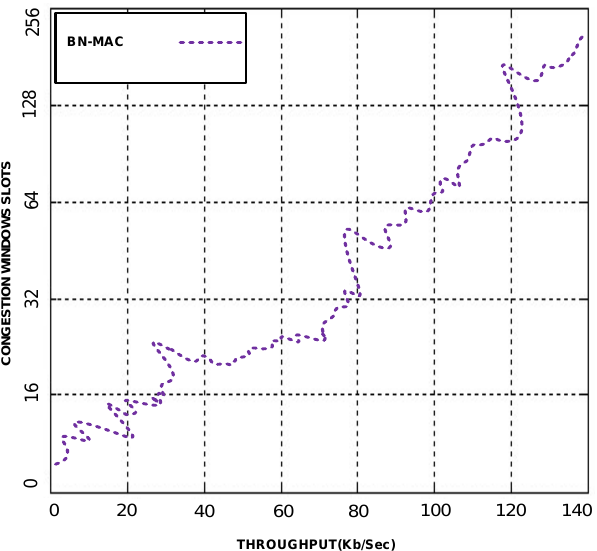
Figure 4. Throughput at different congestion window